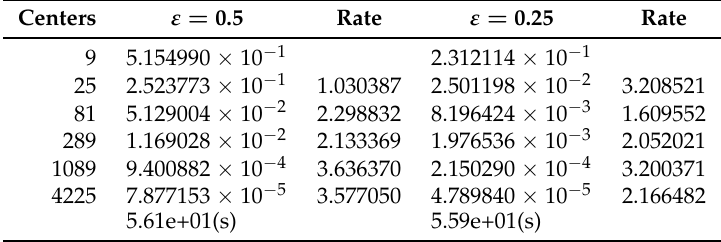
Table 5. CSRBFs collocation: nonstationary.